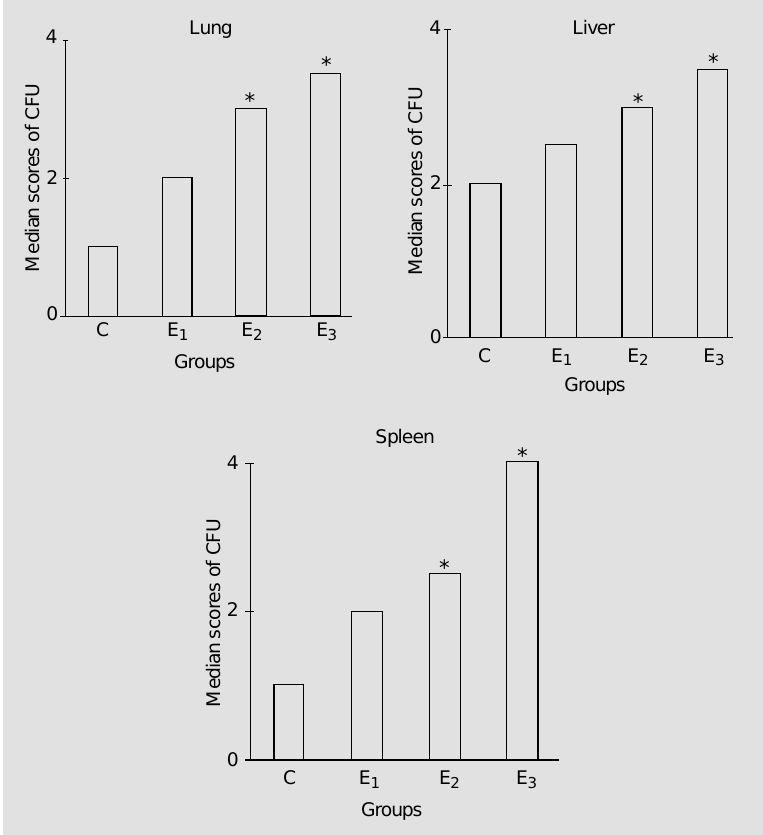
Figure 1 - Scores of M. bovis colony-forming units (CFU) in tissues of hamsters injected with 1.0 (E 1 ), 2.0 (E 2 ) or 3.0 (E 3 ) mg kg -1 day -1 of diazepam or with 1.0 ml kg -1 day -1 of control vehicle solution (group C) for 30 days and inoculated with 0.5 ml of an M. bovis (strain AN-5) suspension. *P<0.05, compared to control (Kruskal-Wallis analysis of